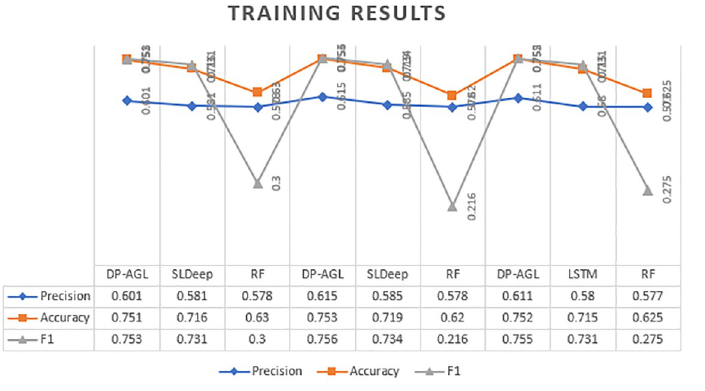
Fig 5. Training result.